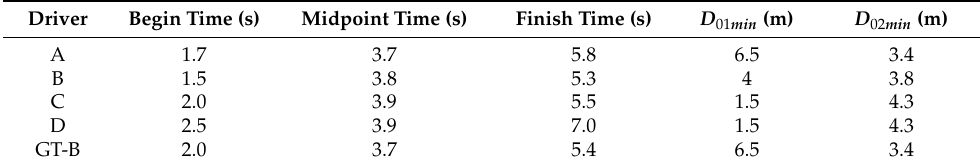
Table 9. Driving parameters of different drivers under Case III.